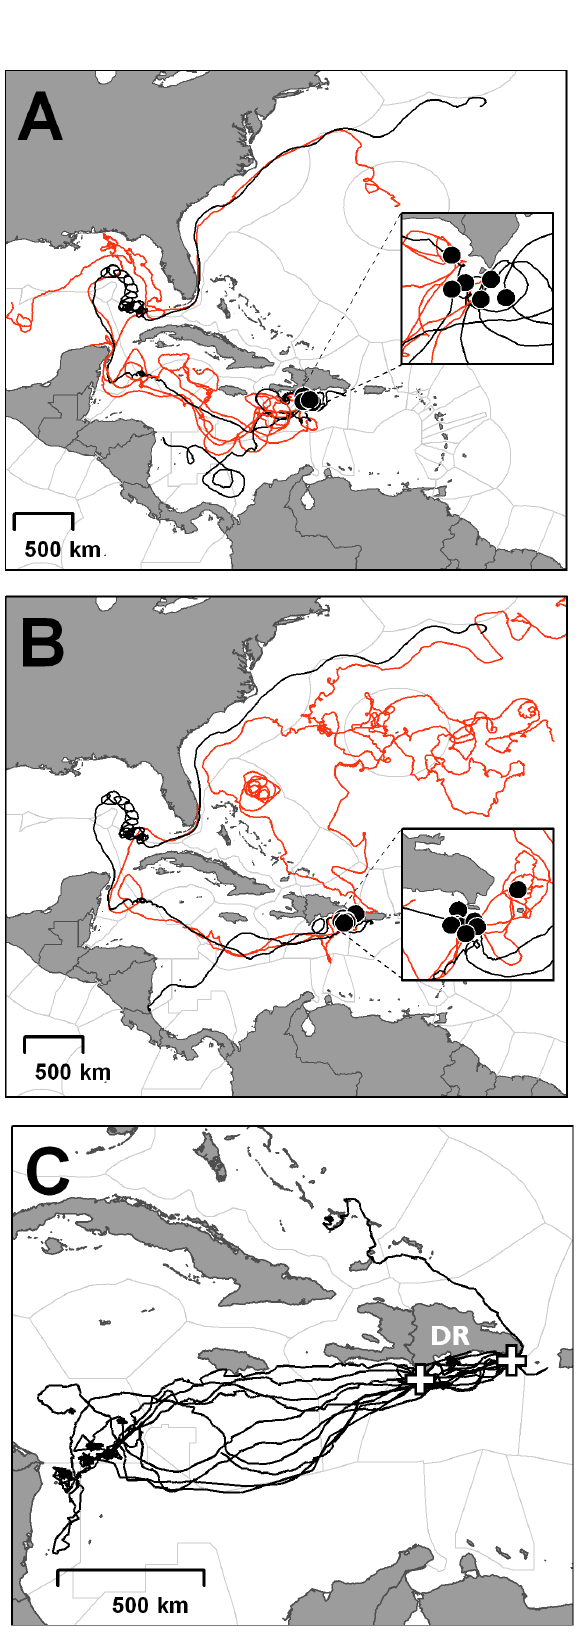
Figure 4. Tracks of passive drifter buoys and satellite traked turtles. (A, B) Tracks of passive drifter buoys on departure from the (A) Jaragua National Park or (B) Saona Island (starting point indicated with black circles). Red lines show tracks on departure during the